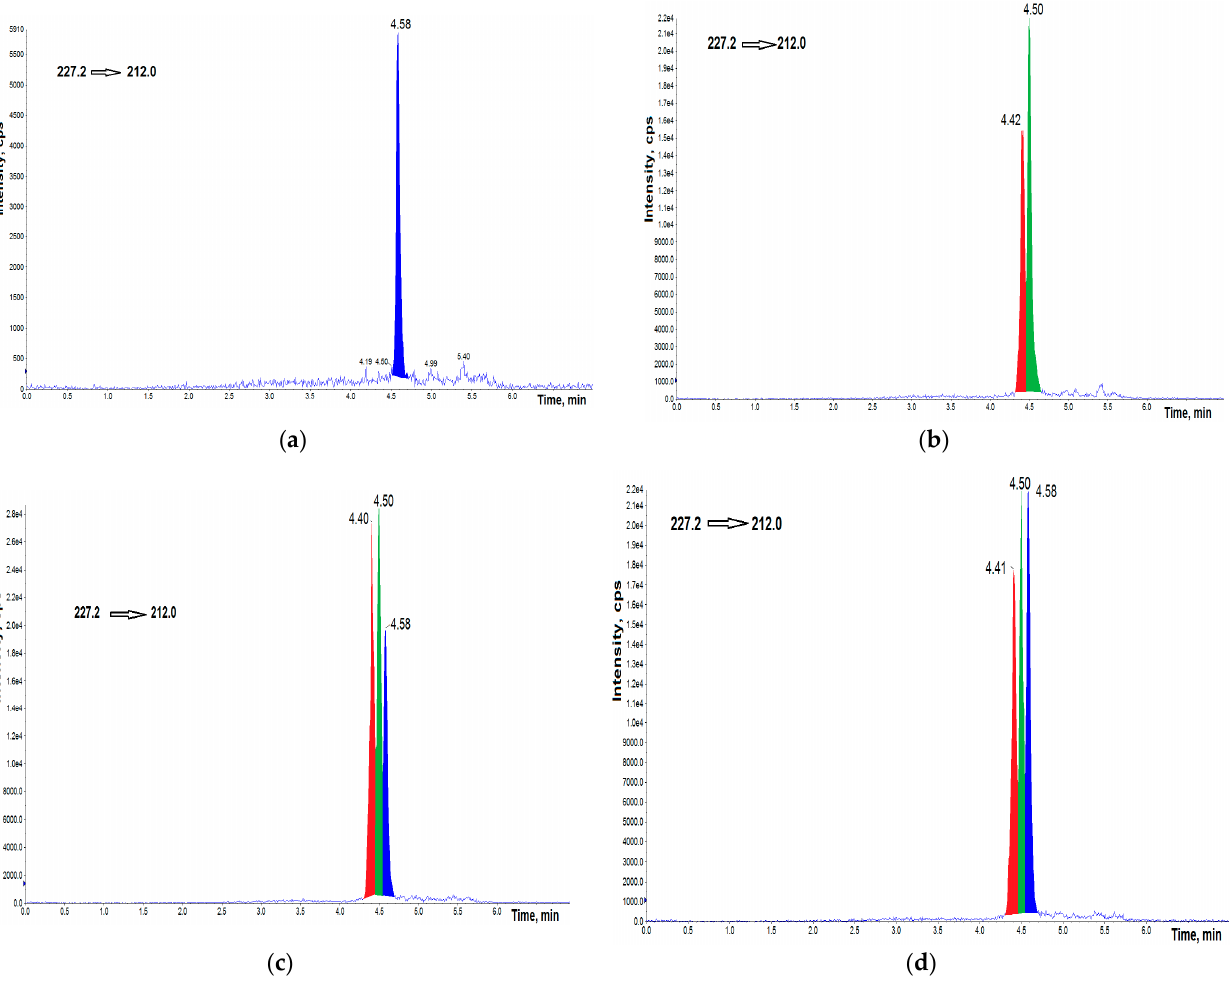
Figure 4. UHPLC–MS/MS chromatogram of AH samples with detected BPA ( a ), AH sample with two detected isomers of BPA ( b ), AH sample with detected BPA and two isomers ( c ), AH sample with BPA and two detected isomers and spiked with 2.0 ng g − 1 of BPA ( d ). cps—counts per second.